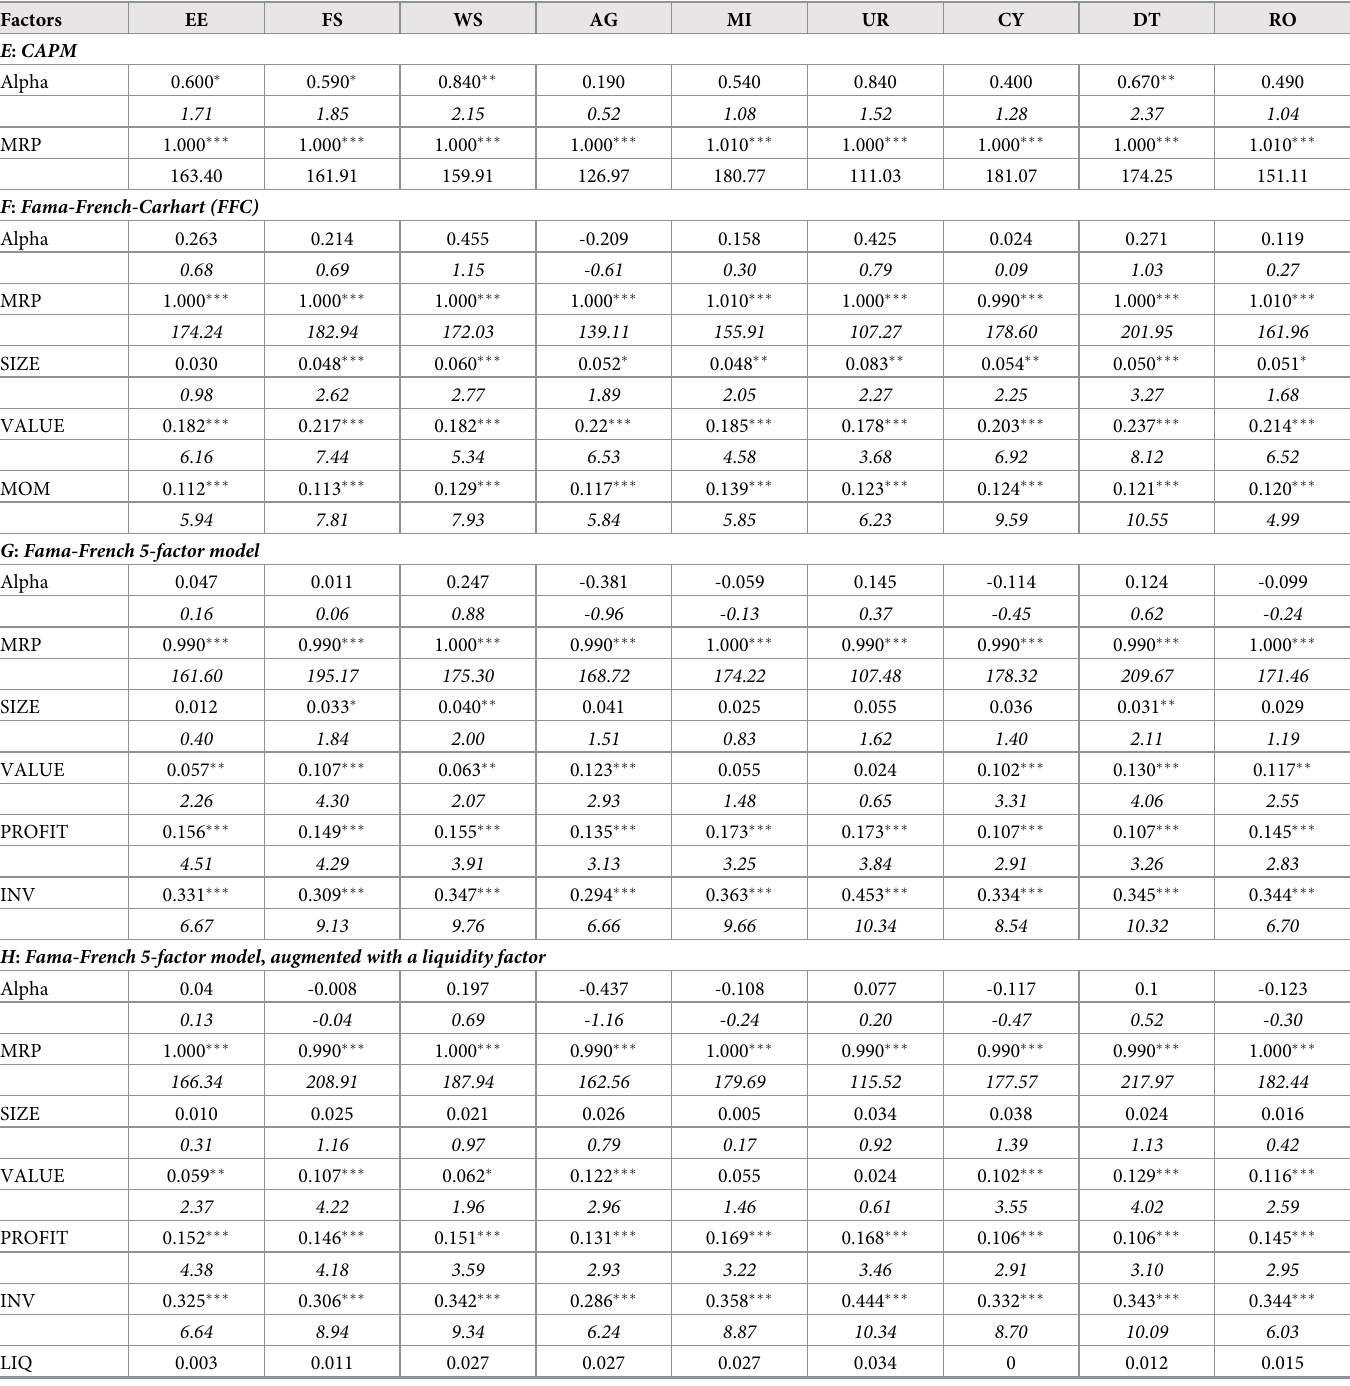
Table 5. Regressions of megatrend portfolios on pure factor portfolios via GMM-IV d